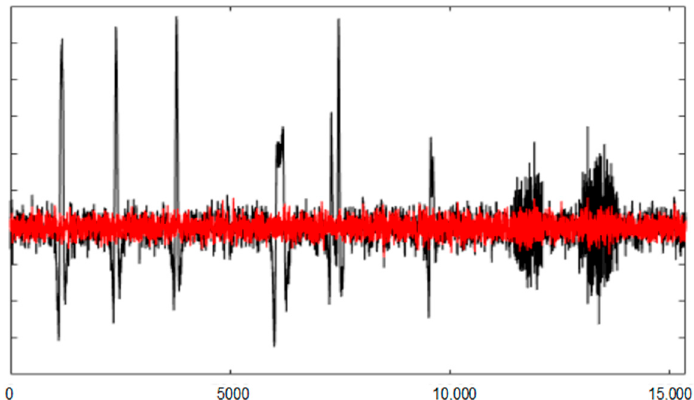
Figure 21. The AF8 channel of SEEG with (in black) and without artefacts (in red) after using SASICA. The X axis shows the samples.